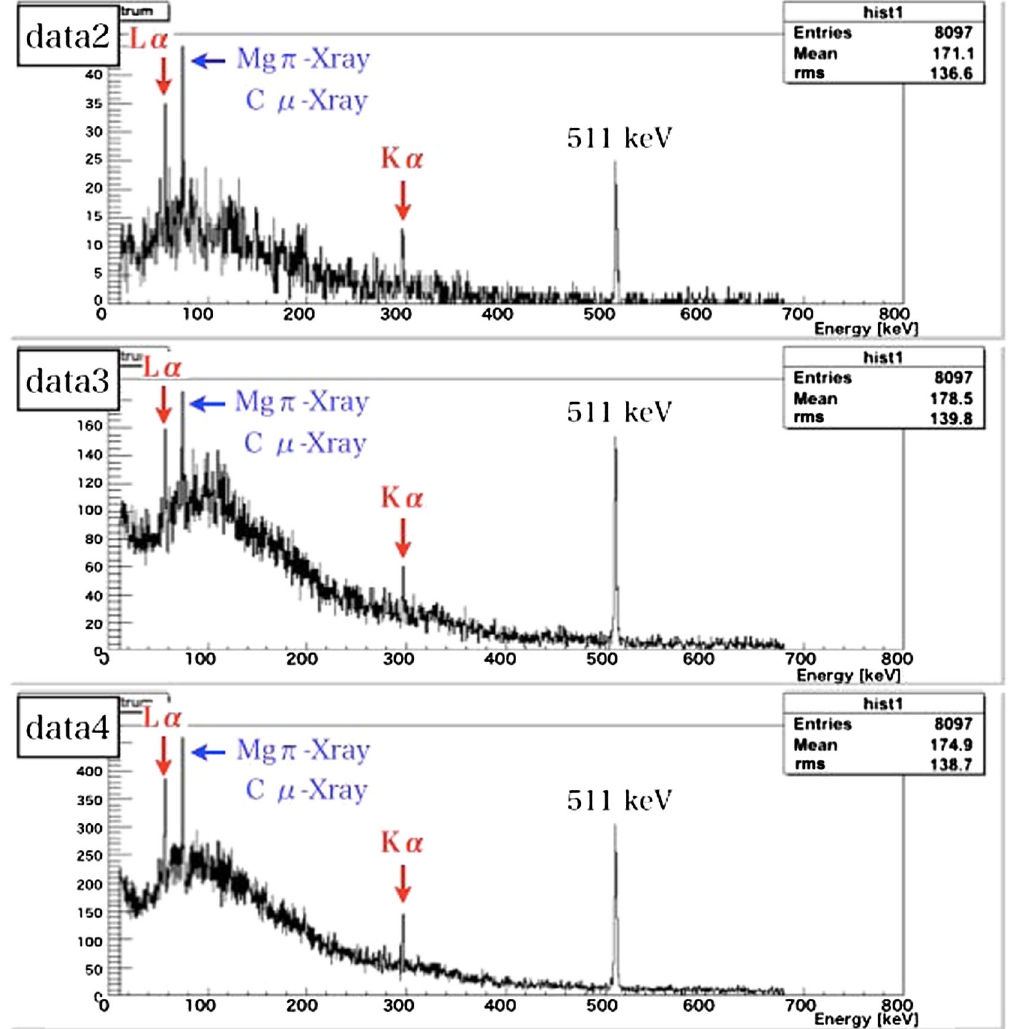
FIG. 4. Muonic x-ray spectra for different data sets.